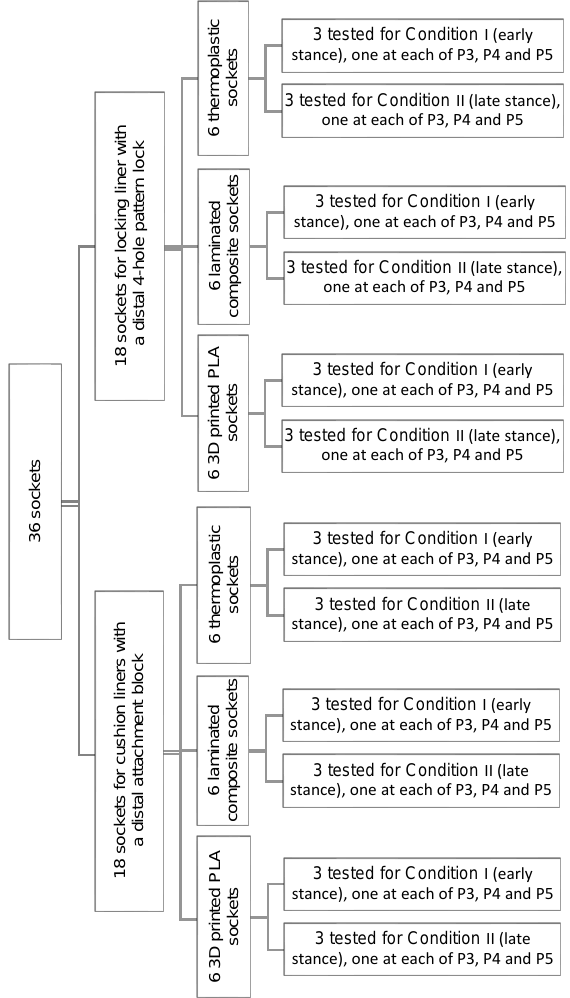
FIGURE 2: An outline of all the sockets that were fabricated for this study, which mold and materials they were made from and which conditions they were tested